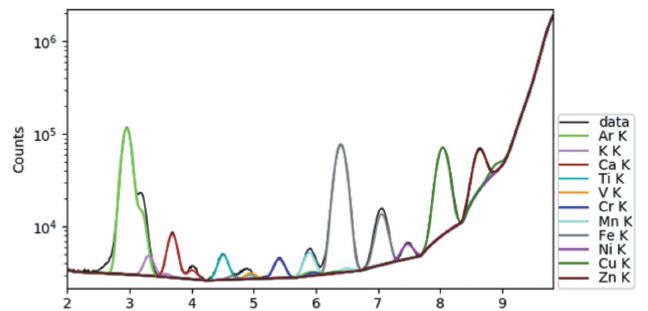
Figure 4 Typical XRF spectrum (patient 2) collected from a biological sample showing the contributions from Ca ( K (cid:2) at 3.691 keV, K (cid:3) at 4.012 keV), Fe ( K (cid:2) at 6.404 keV, K (cid:3) at 7.058 keV) and Zn ( K (cid:2) at 8.638 keV, K (cid:3) at 9.572